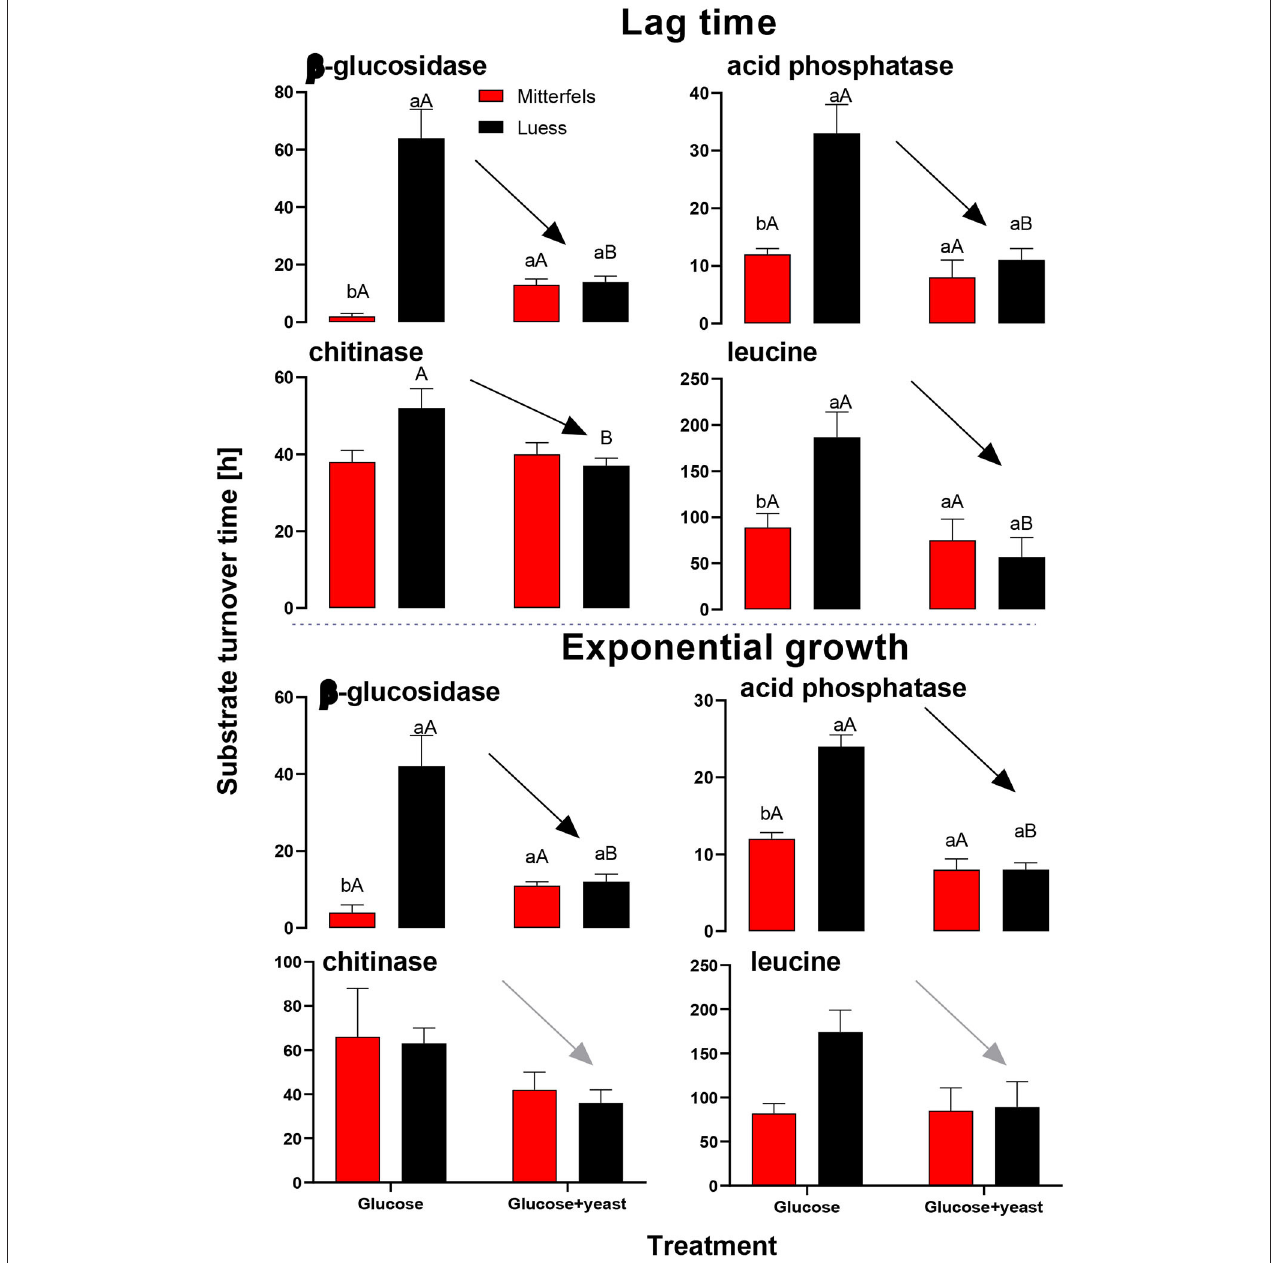
FIGURE 8 | Substrate turnover time of C-, N-, and P-cycling extracellular enzymes during lag phase and exponential growth of microorganisms according to Tischer et al. (2015). The nutrient-poor site is shown by black and the nutrient-rich by red bars. As substrates either glucose or the combination of glucose and yeast extract was added to two soils of nutrient stocks ( Table 1 ). Significant differences between substrate addition were denoted by capital letters at a level of significance of P < 0.05. Lower letters indicate the significant differences between the sites at identical level.